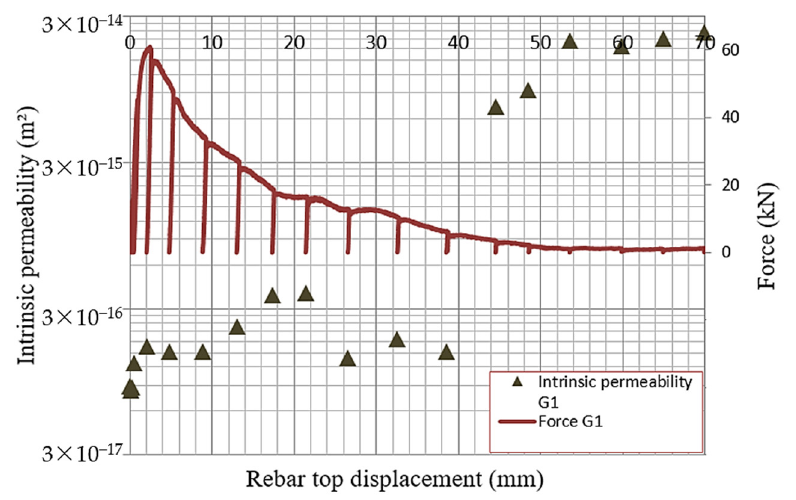
Figure 26. Push-in test evolution of the transfer properties for specimen G1 (Adapted with permission from reference [57].